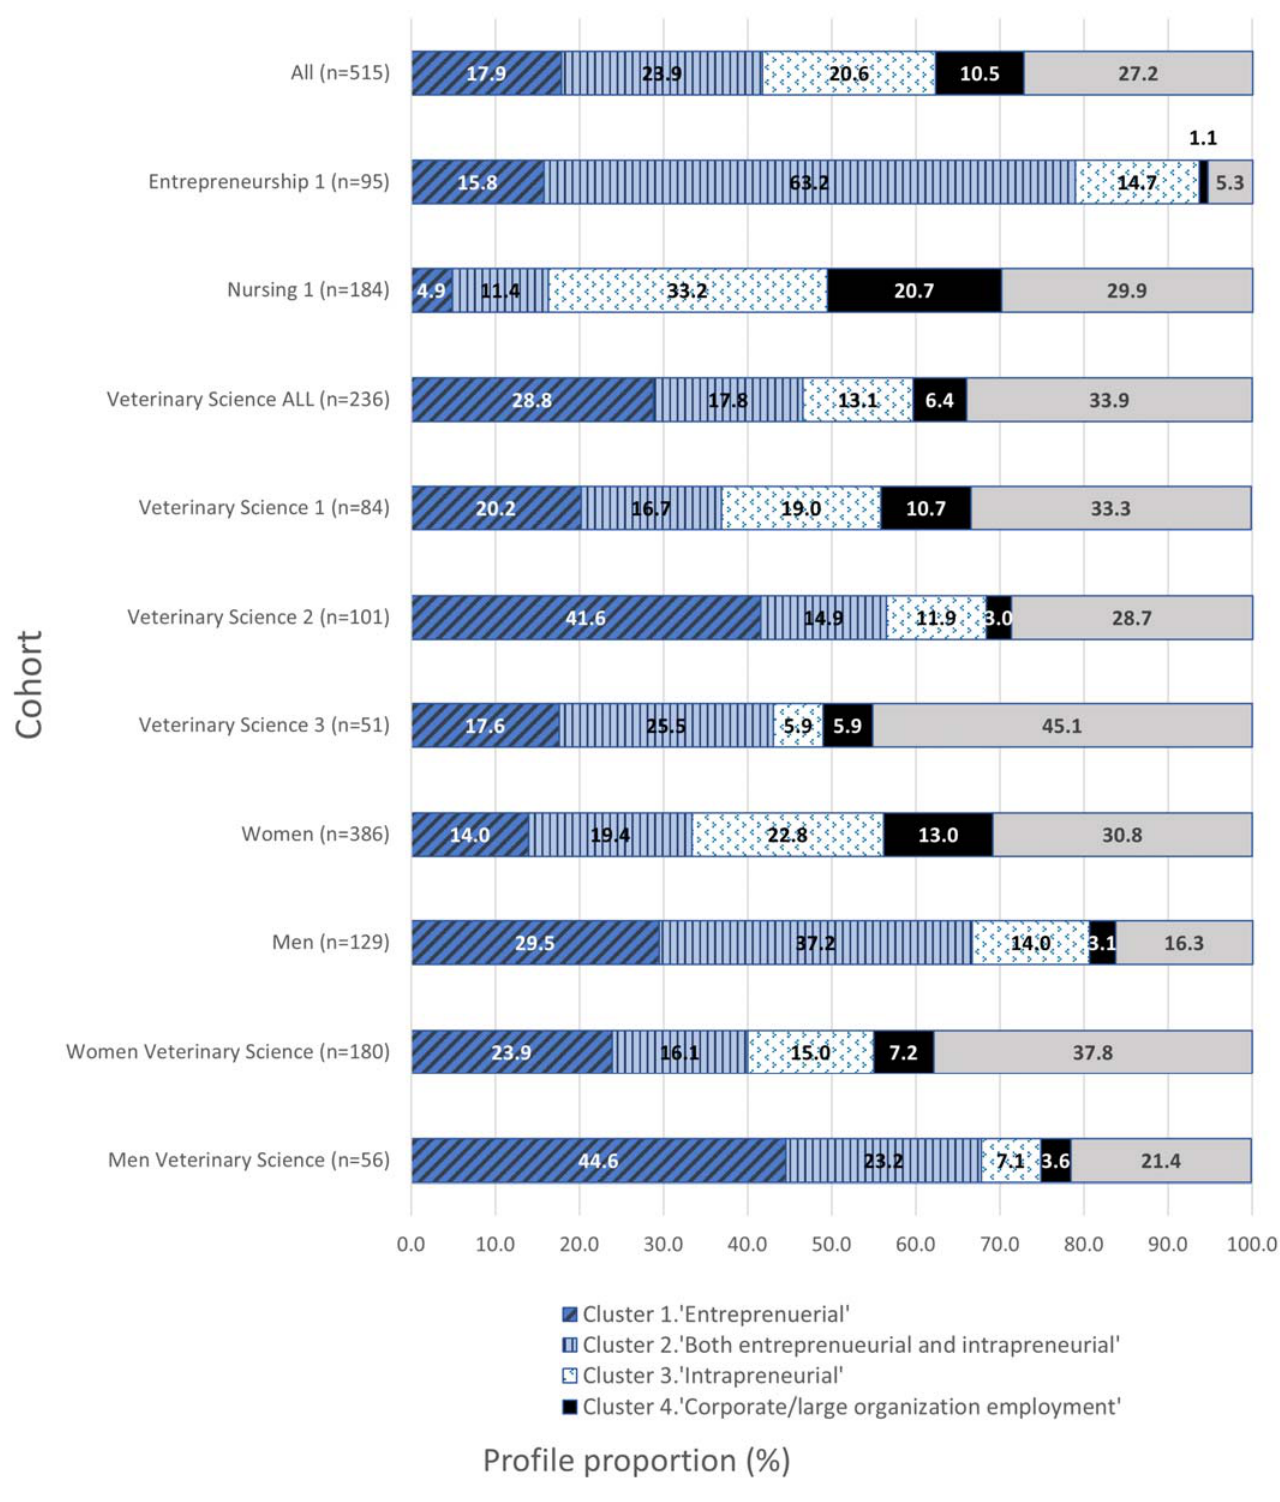
Figure 4. Profile proportions per field of study, veterinary school, and gender.